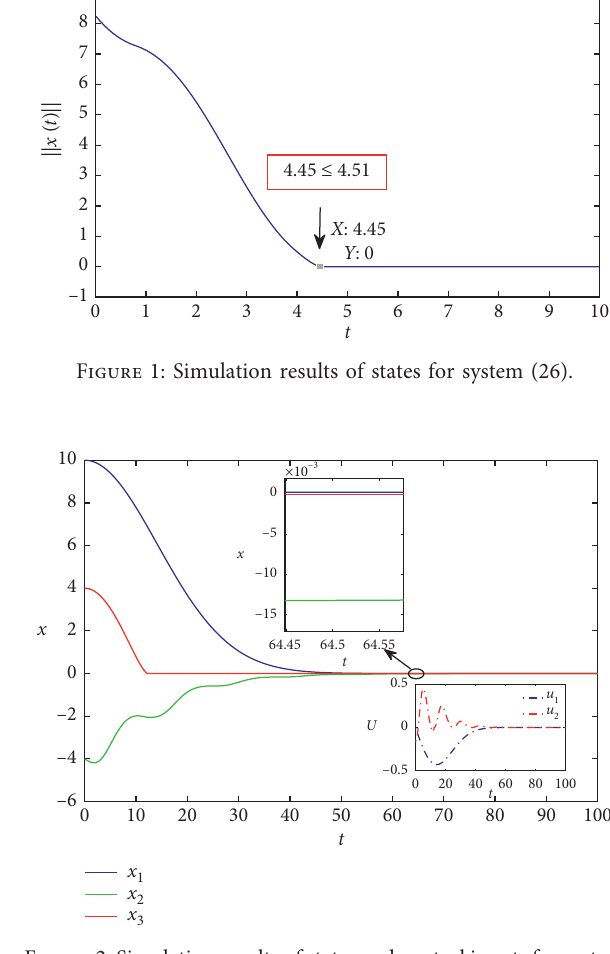
Figure 2: Simulation results of states and control inputs for system (10).